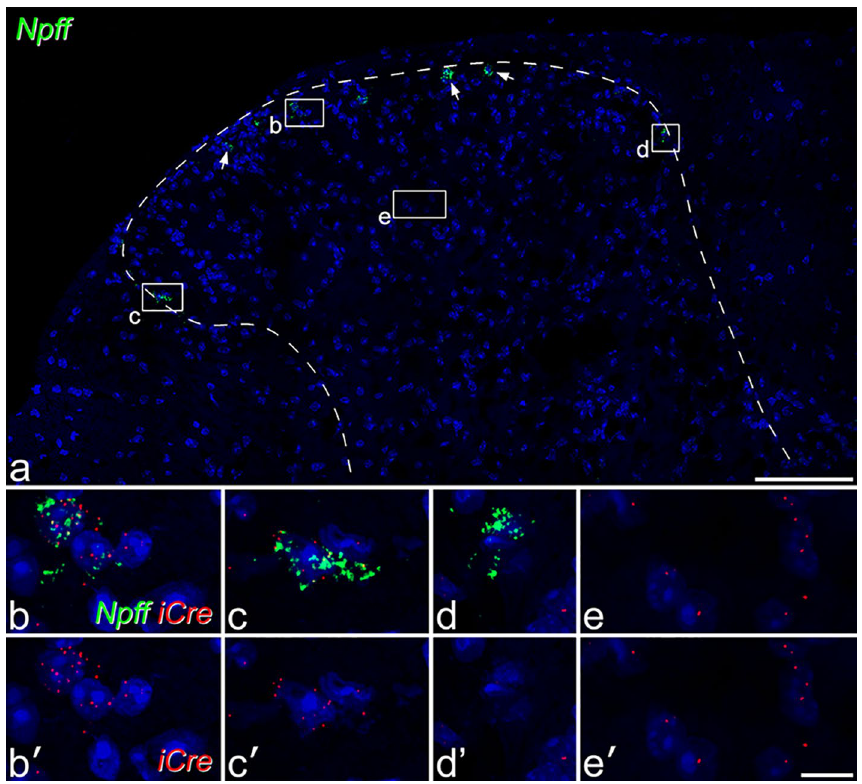
Figure 4. Fluorescence in situ hybridisation labelling for iCre and Npff in the lumbar spinal cord. ( a ) shows labelling for Npff mRNA (green) in a section counterstained with NucBlue (blue). Several Npff -positive cells are present in the superficial dorsal horn, and some of these are indicated with arrows. Boxes indicate the locations of the regions shown in ( b )–( e ). Note that labelling for iCre mRNA is not visible at this magnification. ( b )–( e ): higher magnification views showing the relationship between mRNAs for Npff (green) and iCre (red). Most of the cells with Npff also contain several particles representing iCre , and examples are shown in ( b ) and ( c ). However, some Npff -positive cells are negative for iCre , and an example is shown in ( d ). Throughout the dorsal horn, many cells that lack Npff contain a small number of particles corresponding to iCre as shown in ( e